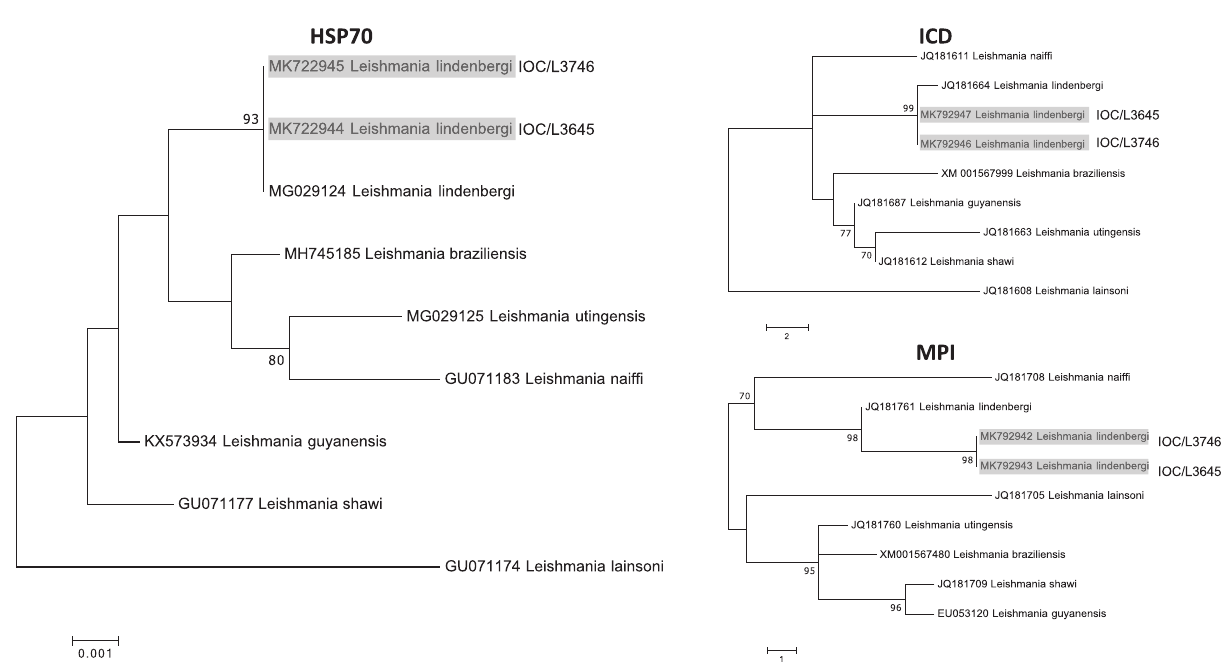
Figure 4. Neighbor-joining trees based on the analysis of partial sequences of hsp70 , icd and mpi for L . ( Viannia ) species, indicating the identity of IOC/3645 and IOC/L3746 with L . lindenbergi . Bootstrap test (1000 replicates) was performed and values above 70% are shown. The trees are drawn to scale. The evolutionary distances were computed using the number of differences method [8]. GenBank accession numbers for each sequence are presented before the name of the species corresponding to each